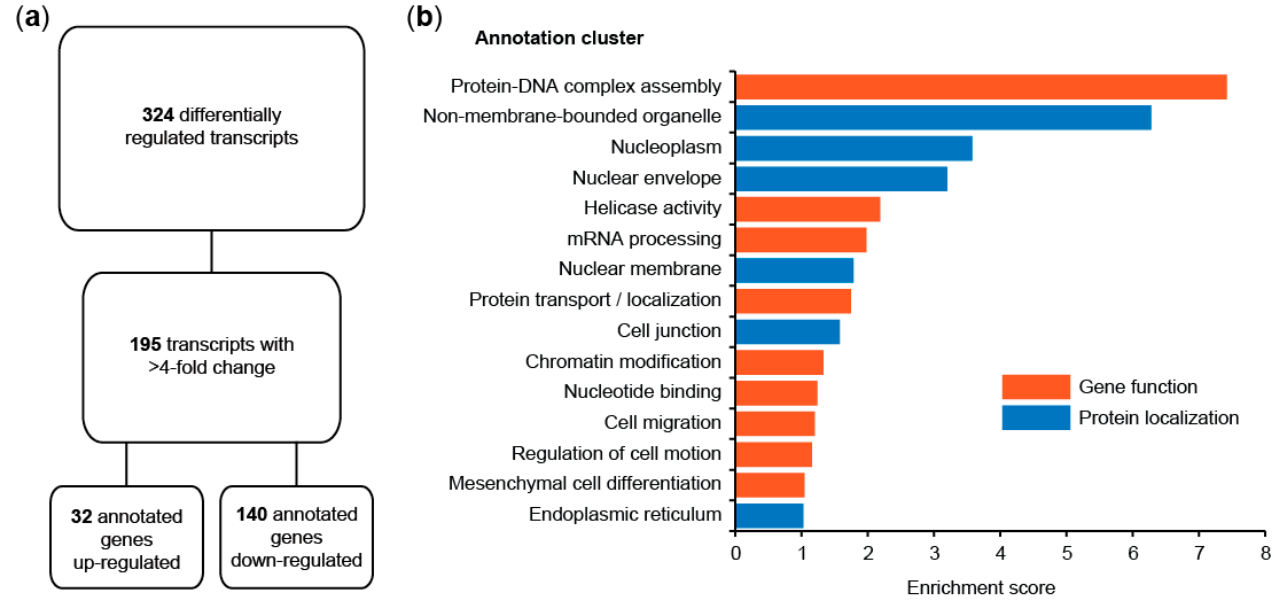
Figure 1. S100A4-dependent transcriptome analysis in HAB92 CRC cells. ( a ) Two color microarray analyses of differentially expressed genes in HAB92/S100A4 cells vs. HAB92 and HAB92/vector cells. ( b ) Annotation cluster analysis of 195 transcripts with a more than four-fold change in expression, classified by gene function and protein localization.